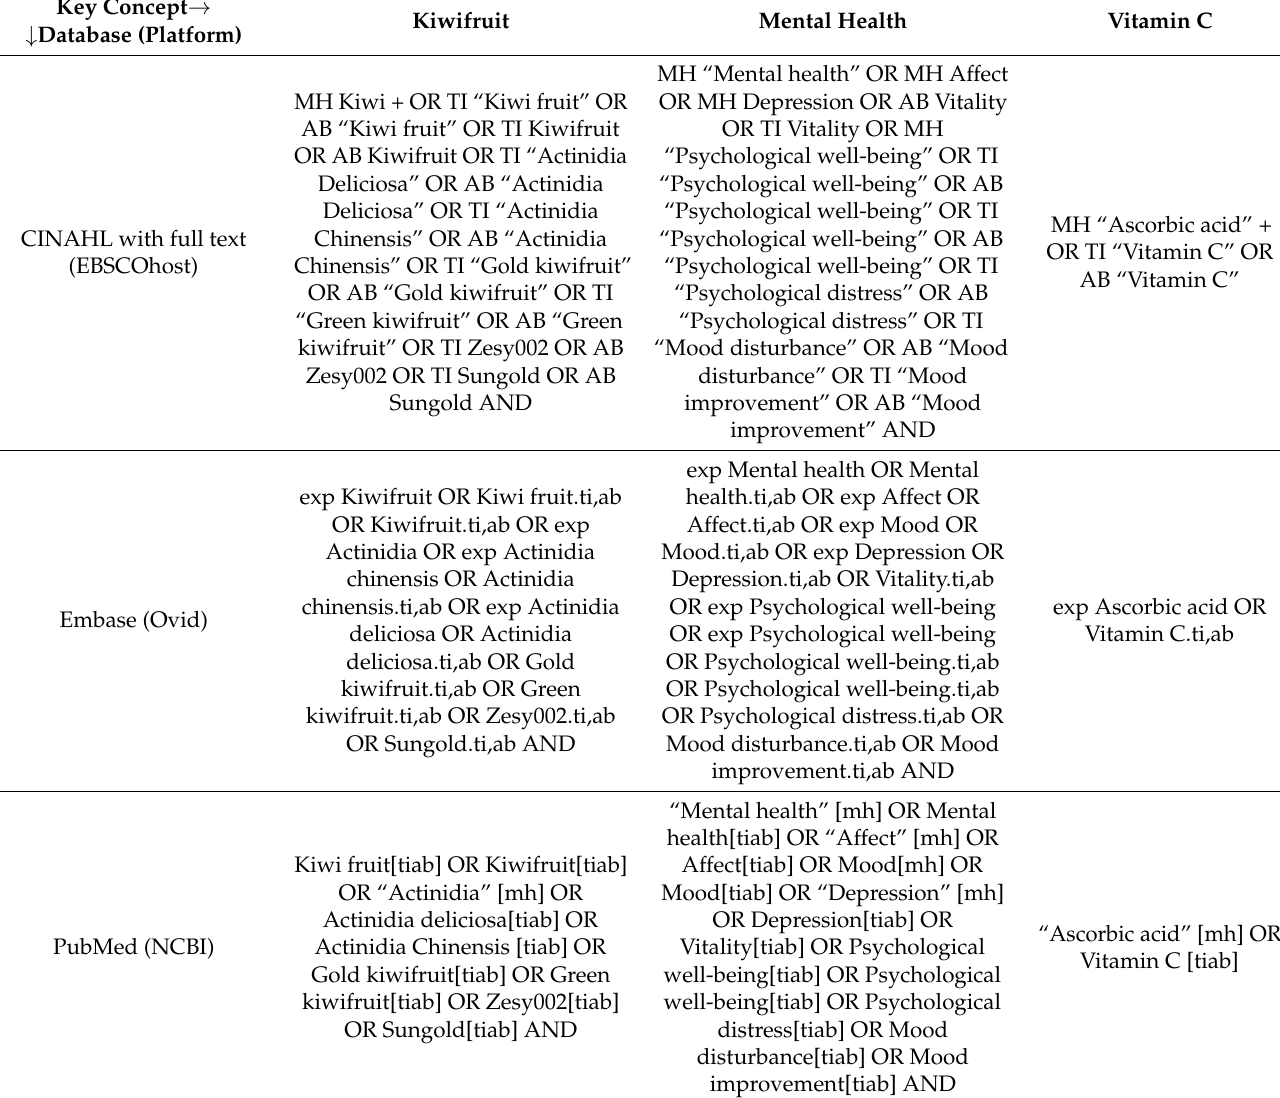
Table 1. Search terms (search conducted 5 July